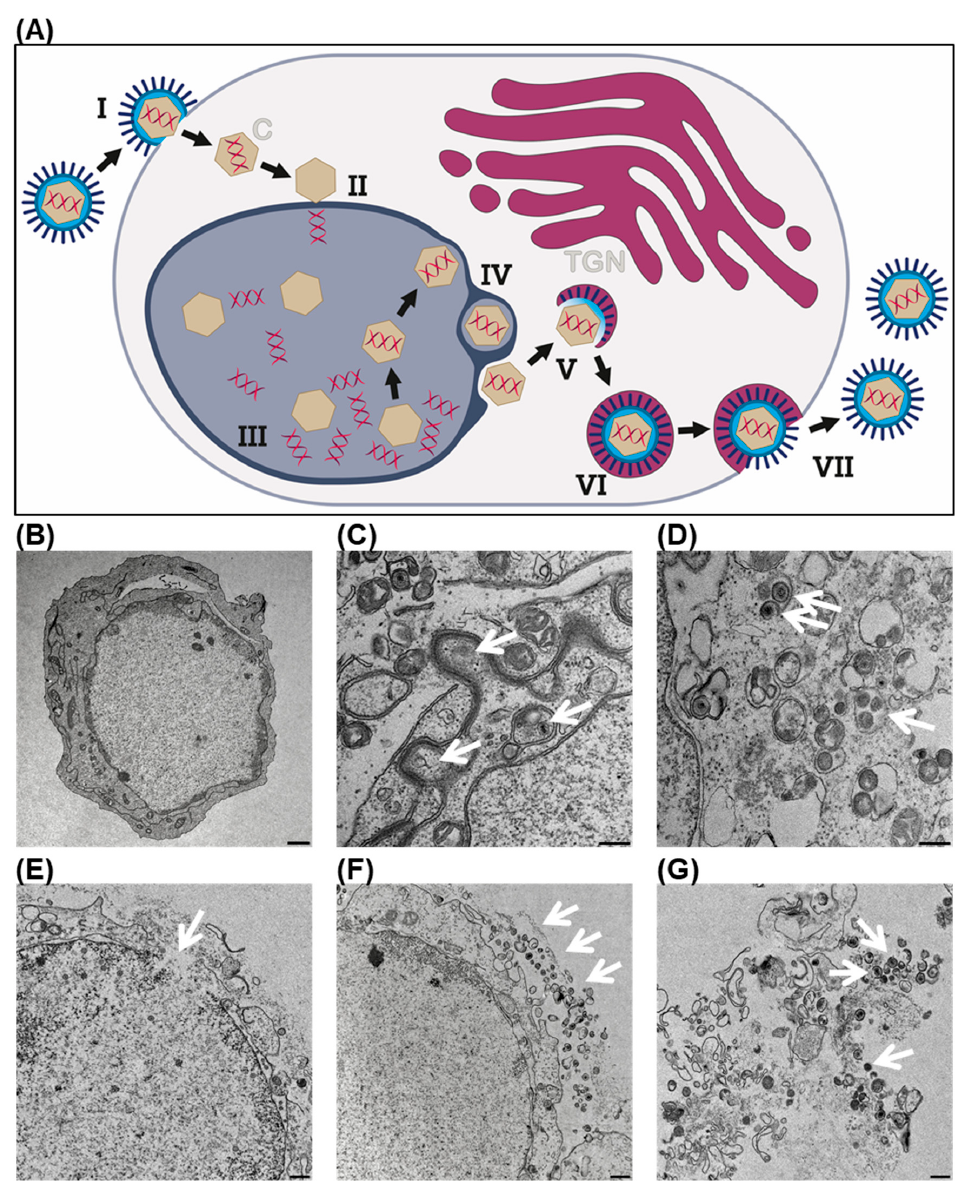
Figure 1. The life cycle of a herpes-simplex-virus type 1 (HSV-1)-based virotherapeutic (T-VEC) ( A ) and transmission electron microscopy (TEM) images of T-VEC-infected HCC2429 NUT carcinoma cells at 48 h post infection (hpi), illustrating individual steps of HSV-1 propagation ( B – G ): ( A ) (I) Glycoproteins located on the surface of HSV-1 virus particles attach to cellular receptors, followed by fusion of the viral envelope membrane with the cytoplasmic membrane of the target cell to release the virus capsid ( C ) into the cytoplasm. (II) The HSV-1 capsid migrates along the cytoskeleton to the cell nucleus, where it attaches; the viral DNA is released into the nucleus, leaving the empty capsid behind. (III) In the nucleus, transcription of viral genes and genome replication take place, thus enabling the assembly of progeny viral capsids. (IV) Newly formed viral capsids first attach to the nuclear lamina, are then transported through the inner nuclear membrane, and finally released into the cytoplasm. (V) Final maturation of the capsid occurs via budding into vesicles of the trans-Golgi network (TGN), which contain viral glycoproteins (dark blue spikes). (VI) Enveloped virions within cellular vesicles are transported to the cell surface. (VII) Then, vesicle and plasma membranes fuse in order to release a mature, enveloped progeny HSV-1 virion from the cell. ( B ) Overview of a single T-VEC-infected HCC2429 NUT carcinoma cell. Scale bar shows 1000 nm. ( C ) Transport of newly formed viral capsids (white arrows) through the perinuclear space (step IV in ( A )). Scale bar